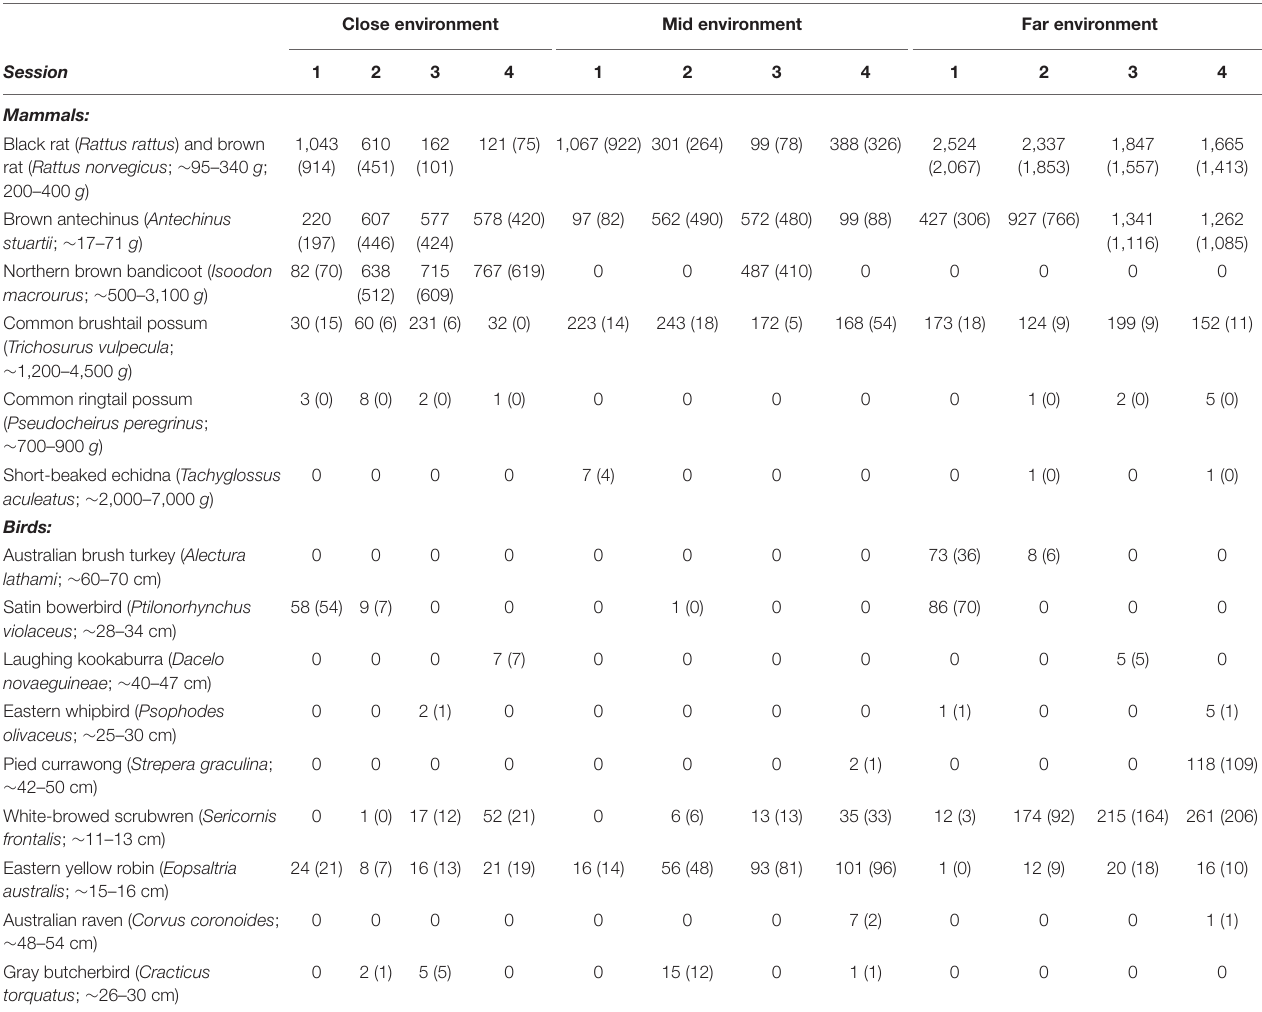
TABLE 2 | The number of videos of potential prey species obtained using infra-red motion-sensor cameras at three locations (“close environment,” “mid environment,” and “far environment”) along an urban disturbance gradient for three nights of pre-treatment conditions and three nights of treatment conditions replicated across four survey sessions in 1 year. The numbers given in parentheses are the number of videos out of the total, given above, that involved foraging in the GUD feeding tray. The remaining number of videos were of the animals in various behaviors in the area surrounding the GUD tray. Weights of mammals are as recorded in Van Dyck et al. (2013). Sizes of birds are as recorded in Morcombe (2012). Additional videos scored were of passing predators, or animals under the acclimatization